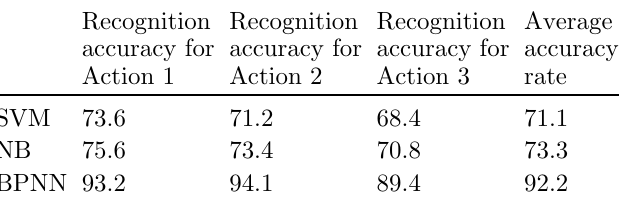
Table 2. Action recognition results.